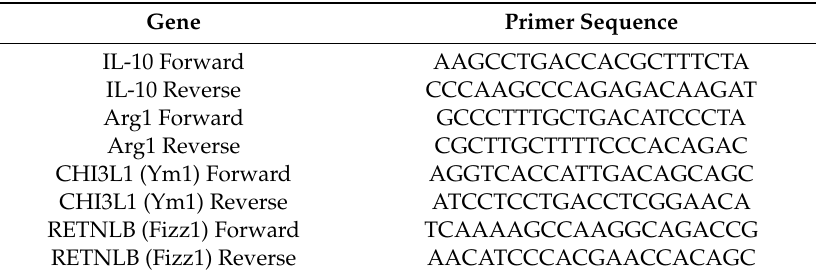
Table 1. Primers used to assess the M2 gene